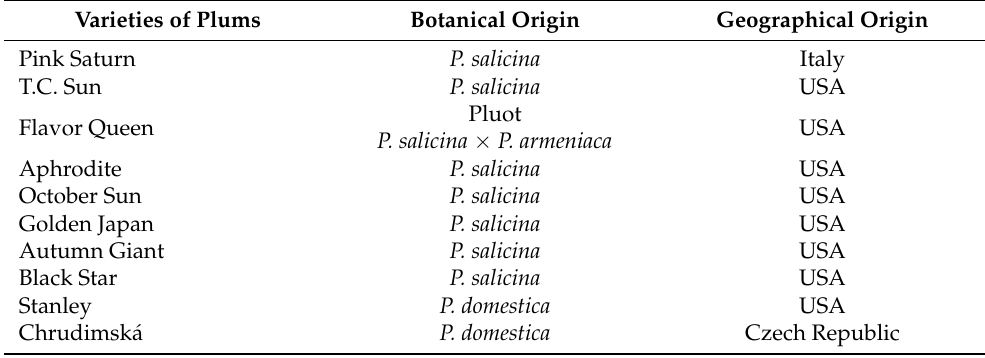
Table 1. Selected plum varieties used for conducting experimental evaluations of nursery traits. Varieties of